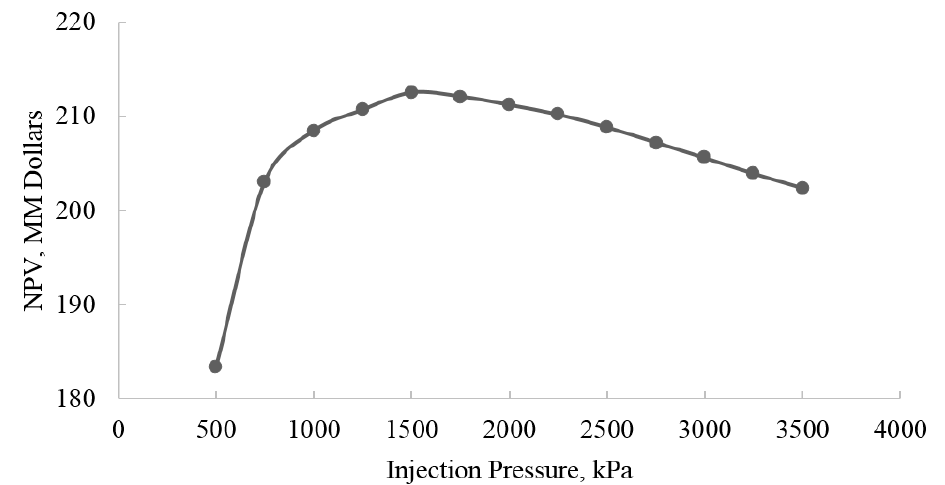
Figure 9. Relationship between NPV and injection pressure.